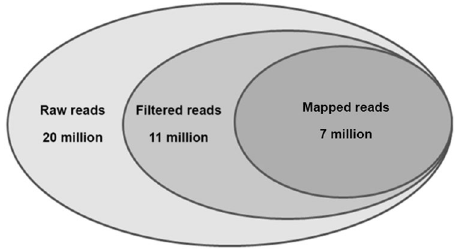
Figure 1. Sequencing results. Deep sequencing results overview showing the average number of raw reads, filtered reads and mapped reads obtained in the small-RNA sequencing experiment. Filtered and mapped reads were analyzed using sRNABench bioinformatics tool.